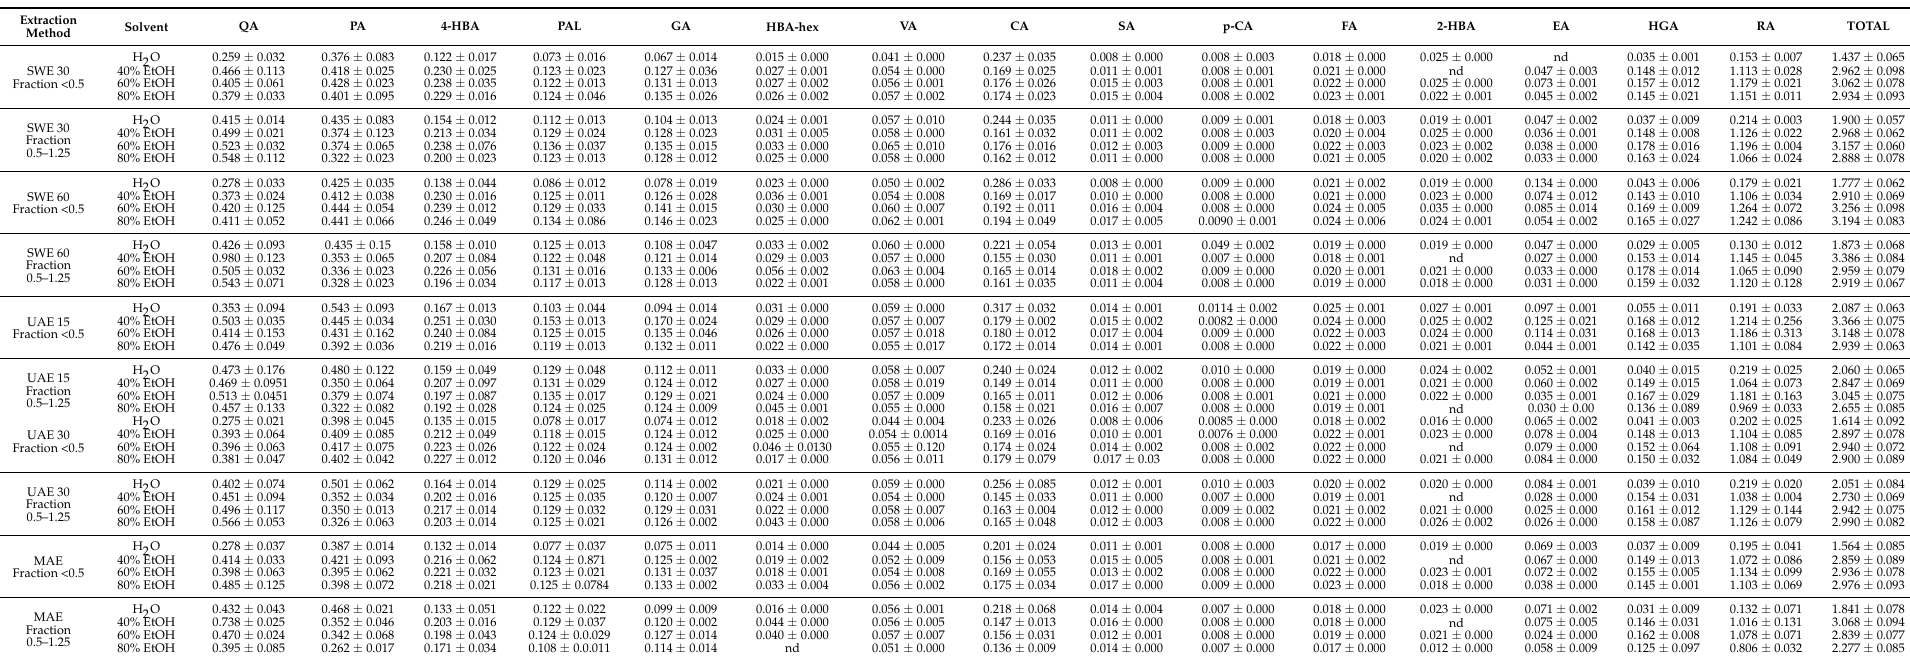
Table 2. Phenolic composition of the extracts obtained with different methods from P. barbatus (Coleus forskohlii ) roots (mg/g